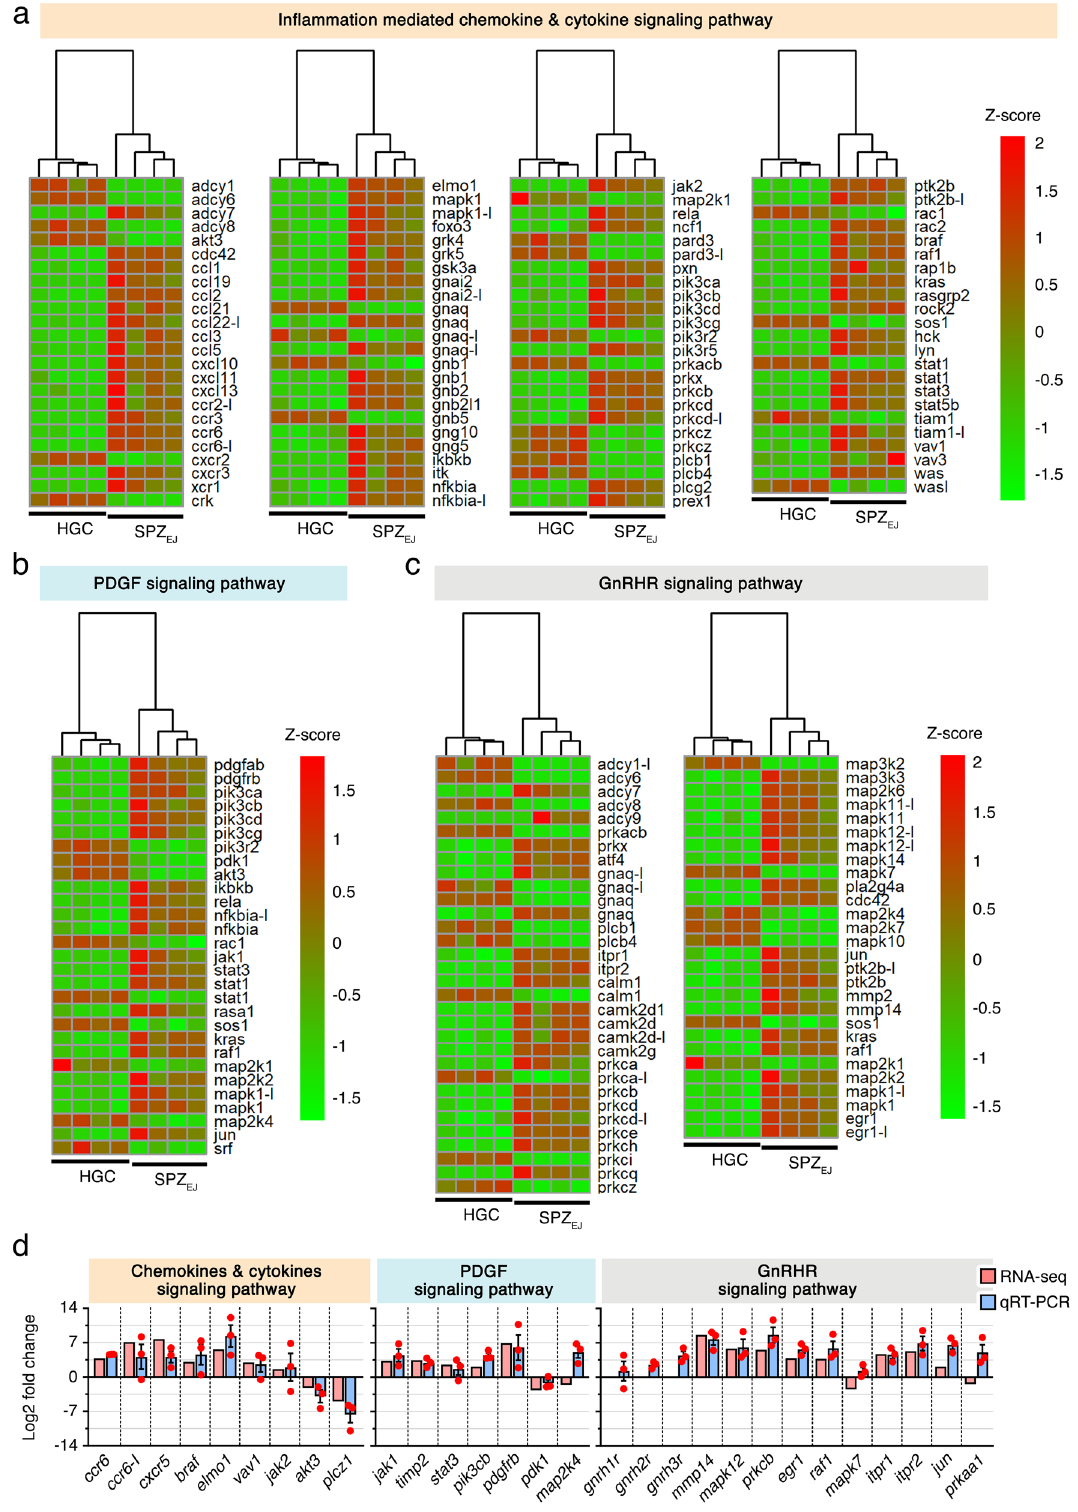
Figure 7. Hierarchical clustering heatmaps of RNA-seq expression for genes potentially involved in the inflammatory chemokine and citokine ( a ), PDGF ( b ) and GnRHR ( c ) signaling pathways. The maps were generated with the ‘pheatmap’ R package (https:// CRAN.R- proje ct. org/ packa ge= pheat map). ( d ) qRT-PCR validation of the changes in expression of selected genes classified into these pathways. Data from qRT-PCR are the mean ± SEM ( n = 3 pools of 3 different fish each) and were plotted using the GraphPad Prism v8.4.3 (686) software (https:// www. graph pad.